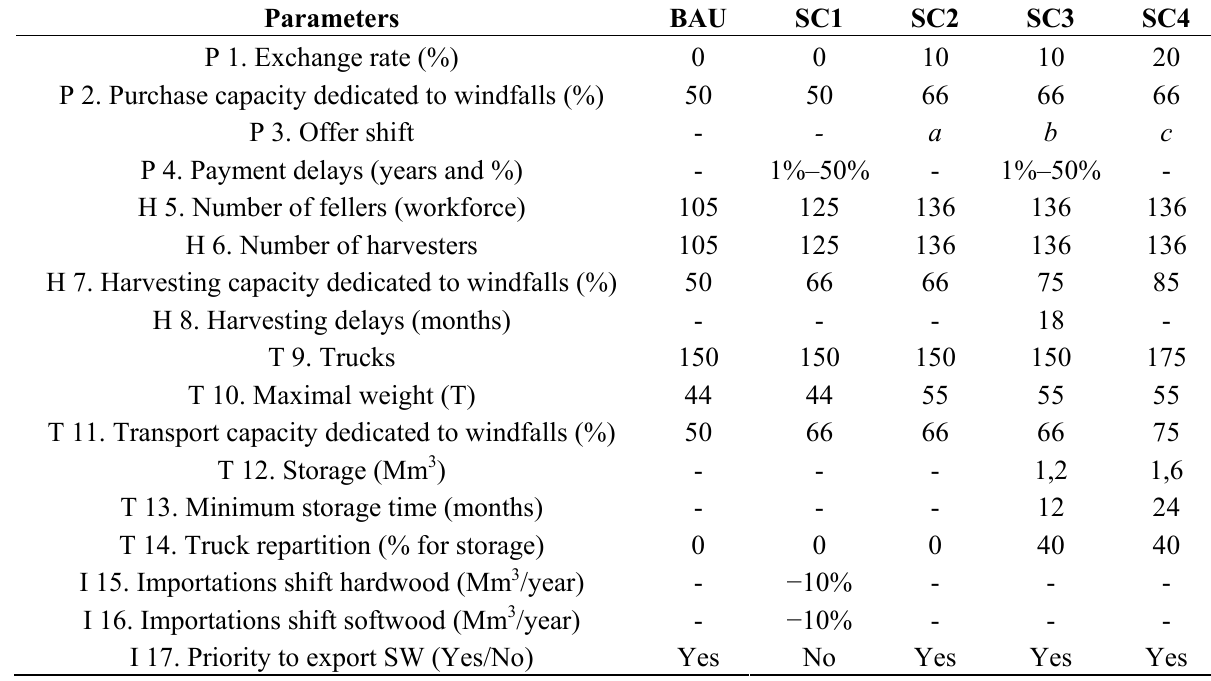
Table 2. Selected parameters for business-as-usual (BAU) and crisis scenarios (SC1 to SC4).